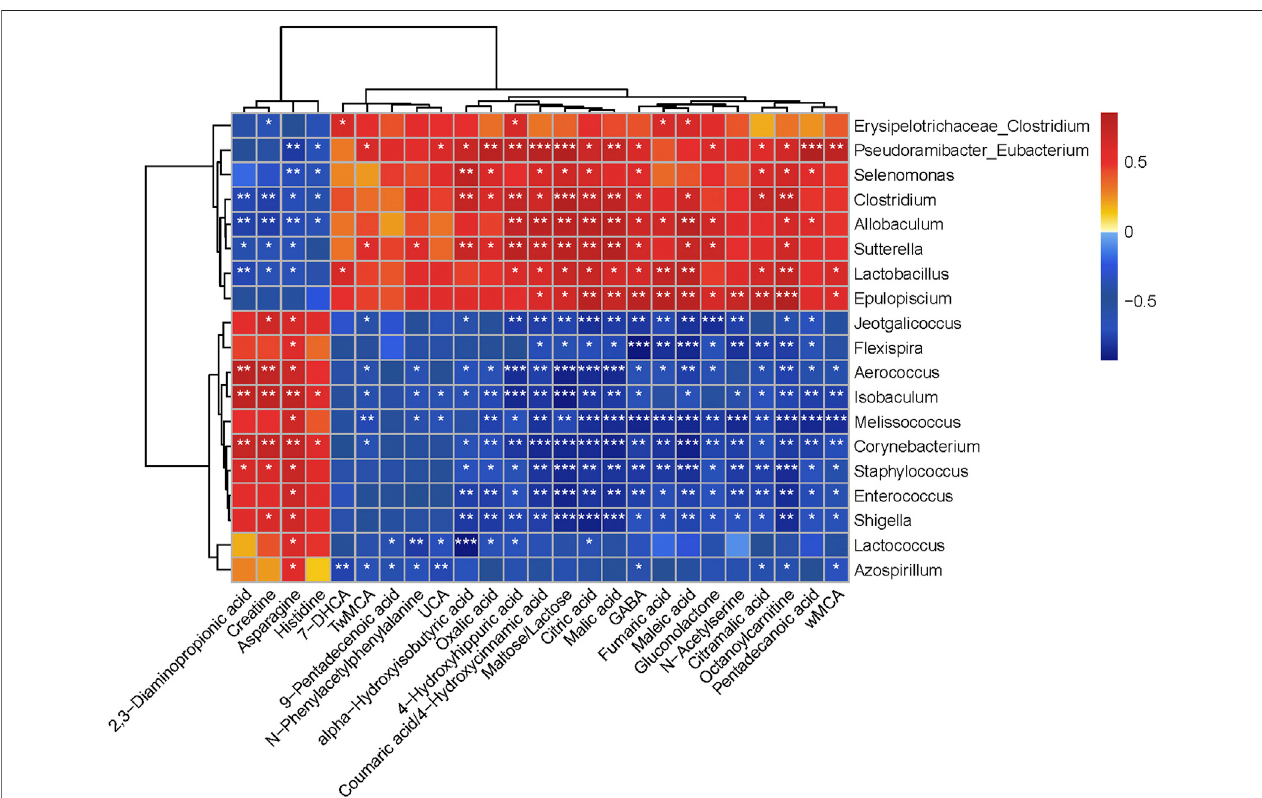
FIGURE5| Heatmapcorrelationbetweenalteredgutmicrobiotaanddifferentcoloniccontentsmetabolites,withstatisticalcorrelationvalues(r) > 0.7.Thervalueis displayedindifferentcolors,withtheredgridindicatingapositivecorrelationandthebluegridshowinganegativecorrelation.Thelargertheabsolutevalueofr,thedarker the grid color. *0.01 ˂ p ≤ 0.05, **0.001 ˂ p ≤ 0.01, *** p ≤